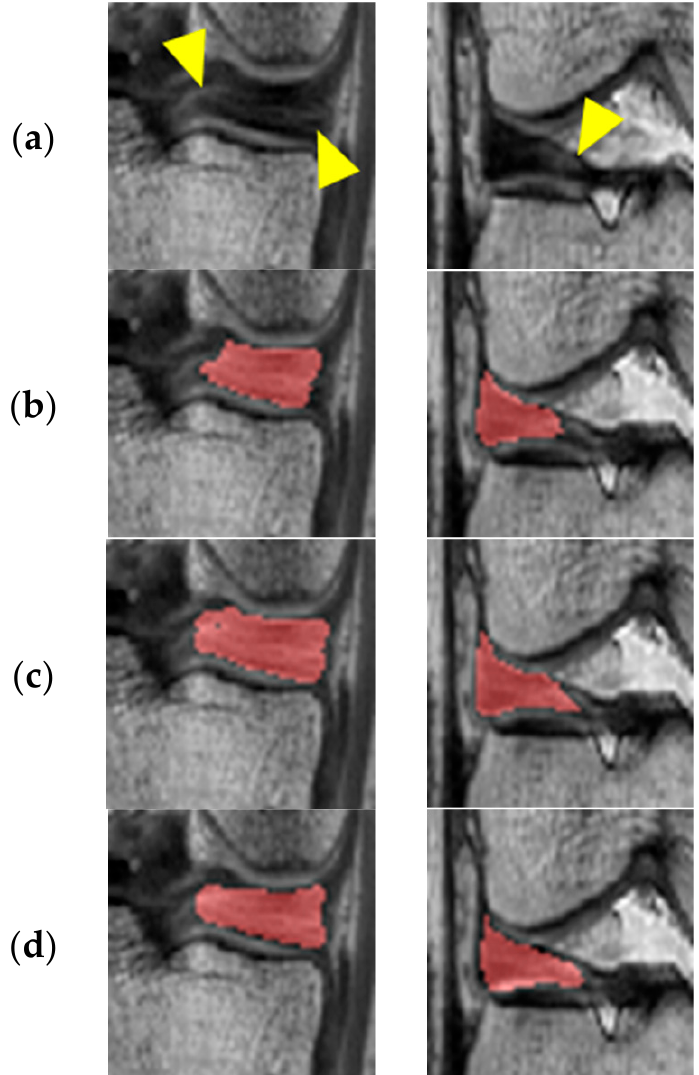
Figure 5. Segmentation results of before and after adversarial learning: ( a ) Original image; ( b ) Before adversarial learning; ( c ) After adversarial learning; ( d ) Ground truth. Figure 6 shows the results of a comparison between conventional adversarial learning and adversarial learning with an object-aware map. In Figure 6, the first and second columns show the results for the medial meniscus, and the third and fourth columns show the results for the lateral meniscus. As shown in Figure 6b, an outlier occurs in the posterior and anterior cruciate ligament sections and over-segmentation arises with the collateral ligament and meniscus boundary because their intensity levels are similar to that of the meniscus in the conventional adversarial network. It can be observed that outliers and over-segmentation results are prevented when using an object-aware map, as shown in Figure